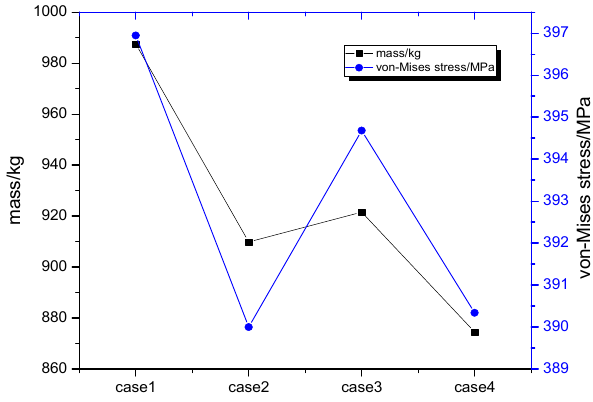
Figure 10. Comparison of maximum von-Mises stress and mass in four cases.